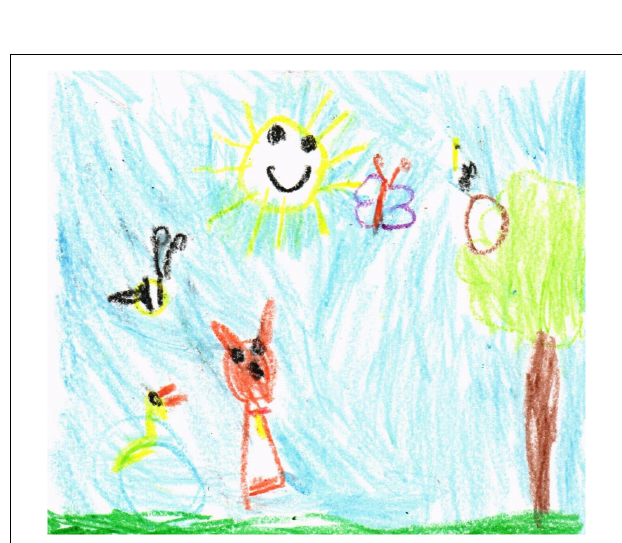
FIGURE 4 | Drawing with support